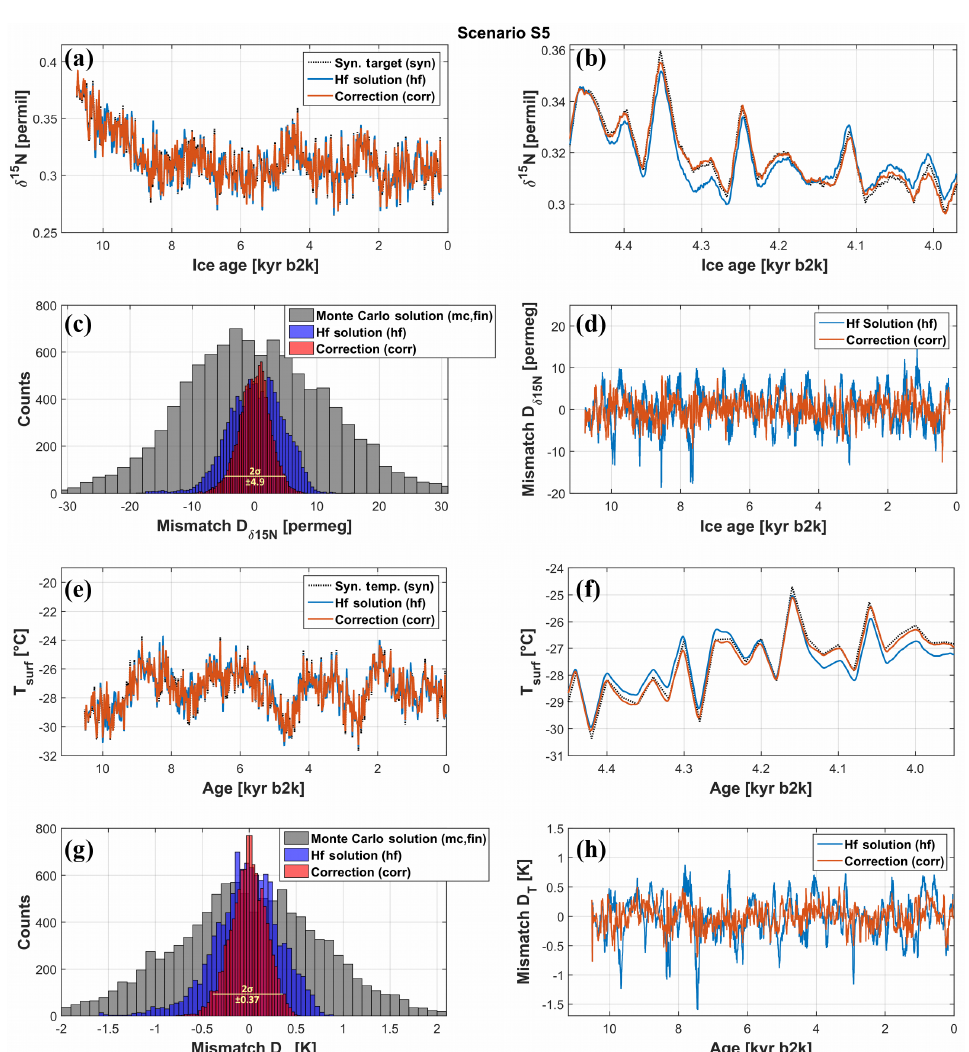
Figure 8. (a–d) δ 15 N: (a) synthetic target δ 15 N syn (black dotted line), modelled δ 15 N time series after adding high-frequency information (hf, blue line) and correction (corr, red line) for the scenario S5. (b) Zoom-in for a randomly chosen 500-year interval shows the decrease of the mismatch after the correction compared to the high-frequency solution. (c) Histogram shows the pointwise mismatches D δ 15 the synthetic target δ 15 N syn versus the Monte Carlo solution (mc,fin; grey), the high-frequency solution (hf; blue) and the correction (corr; red). The 95% quantile is 4.9permeg (yellow line) and used as an estimate for 2 σ uncertainty of the final solution. (d) Time series of the pointwise mismatches D δ 15 of the synthetic target δ 15 N syn versus the high-frequency solution (hf; blue) and the correction (corr; red). N (e–h) Temperature: (e) synthetic temperature target T syn (black dotted line), modelled temperature time series after adding high-frequency information (hf; blue line) and correction (corr; red line). (f) Zoom-in for a randomly chosen 500-year interval shows the decrease of the mismatch after the correction compared to the high-frequency solution. (g) Histogram shows the pointwise mismatches D T of the synthetic temperature target T syn versus the Monte Carlo solution (mc,fin; grey), the high-frequency solution (hf; blue) and the correction (corr; red). The 95% quantile is 0.37K (yellow line) and used as an estimate for 2 σ uncertainty of the final solution. (h) Time series for the pointwise mismatches D T of the synthetic temperature target T syn versus the high-frequency solution (hf; blue) and the correction (corr;